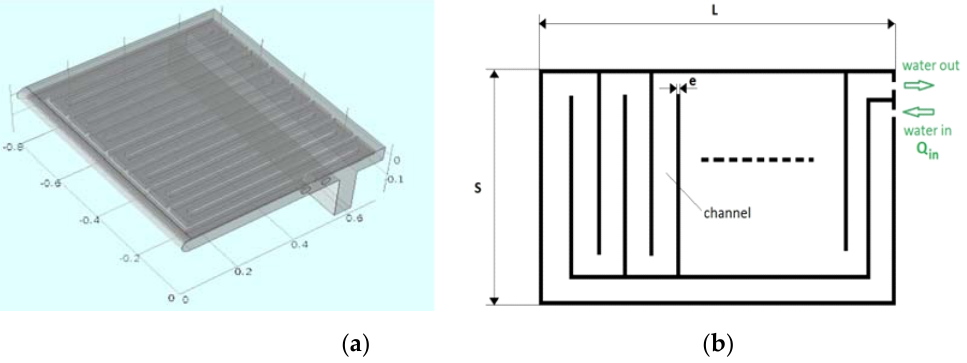
Figure 8. ( a ) A 3D model for the new plate design; ( b ) sketch of the cooling channels.